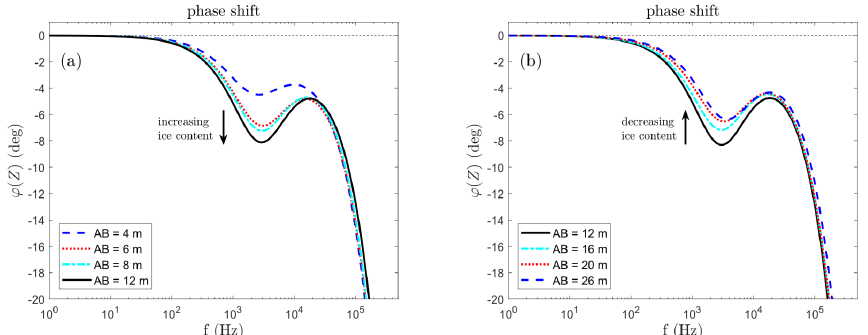
Figure 8. Calculated phase shift spectra for the Cole–Cole models used to fit the Schlumberger sounding data for the spacings AB = 4– 12m (a) and for AB = 12–26m (b) . The model fit of the data AB = 12m (black curve) is shown in both panels. All curves show a strong frequency dependence between 10 2 –10 5 Hz, whereby the intensity of phase peak gradually increases up to the spacing AB = 12m and decreases again for larger spacings, indicating an increase and decrease of ice